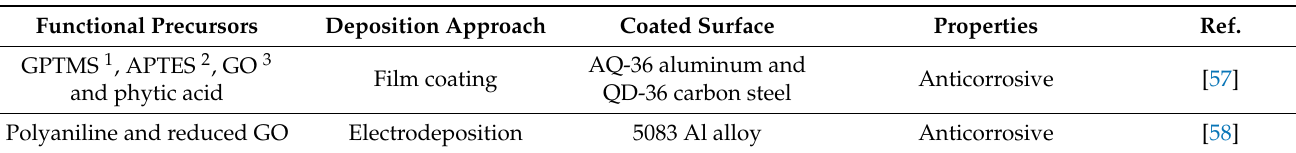
Table 1. Some recent developments in the design and application of functional and sustainable coatings based on natural substances, waste-derived compounds, waterborne formulations and eco-friendly